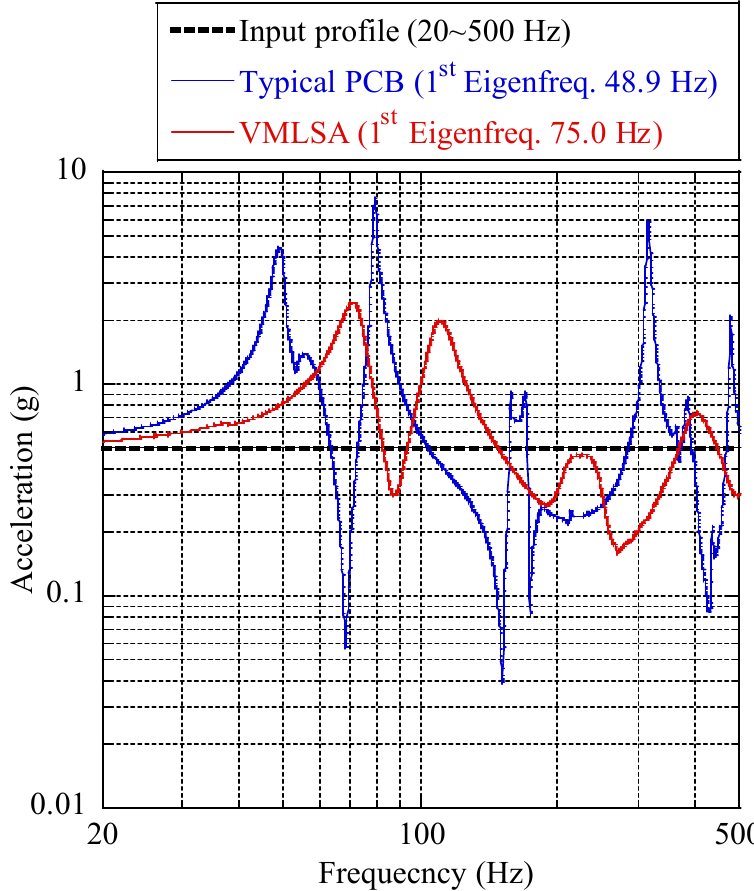
Figure 14. Low-level sine sweep test results in z -axis excitation.